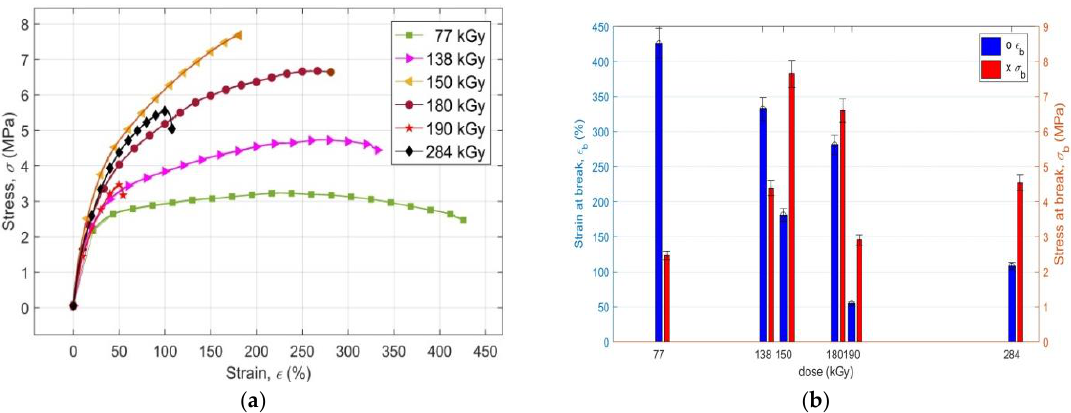
Figure 2. ( a ) Presentation of the values of strain at the break ε b and of stress at break σ b of the polymeric system PMX4 for various radiation doses; ( b ) The effect of the radiation dose on the values of strain at break ε b and stress at break σ b of the polymeric system PMX3.